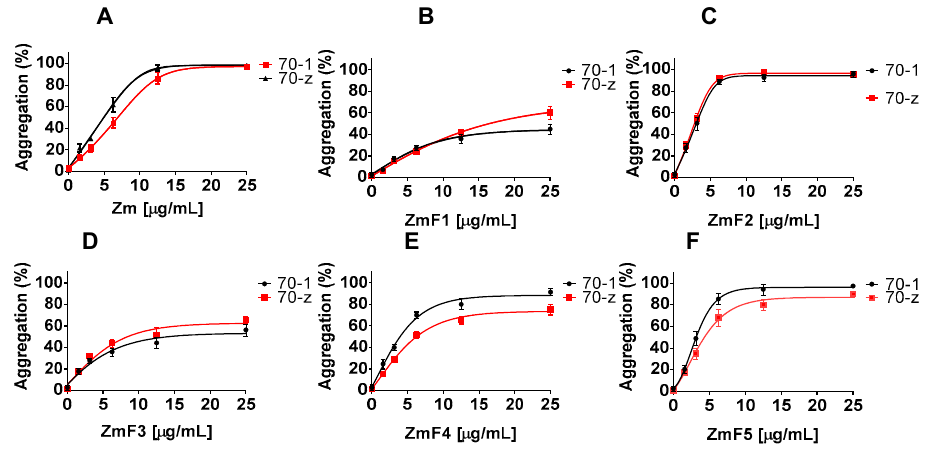
Figure 2. Inhibition of the chaperone activities of PfHsp70-1 and PfHsp70-z by Z. mucronata extracts. Heat induced aggregation of MDH was monitored in the presence and absence of PfHsp70-1/PfHsp70-z (70-1/70-z) at 48 °C for 60 min. The resultant aggregates were estimated at 360 nm. The values were normalized to aggregation of spontaneous MDH aggregation in the absence of PfHsp70-1/PfHsp70-z. Data obtained in the presence of various plant extracts is provided: ( A ) Zm, ( B ) ZmF1, ( C ) ZmF2, ( D ) ZmF3, ( E ) ZmF4, ( F ) ZmF5. Standard deviations obtained from three replicate assays are shown.